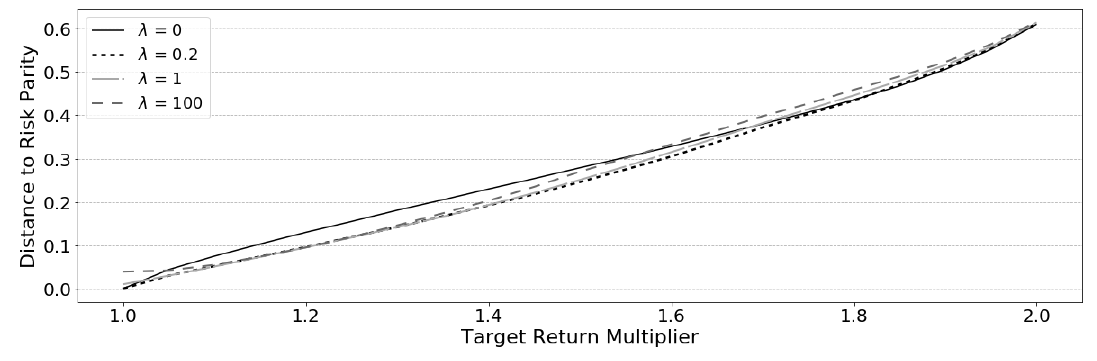
Figure 8. Distance to Risk Parity Mean-Squared-Error (MSE)—2009–2018—Bull Market.